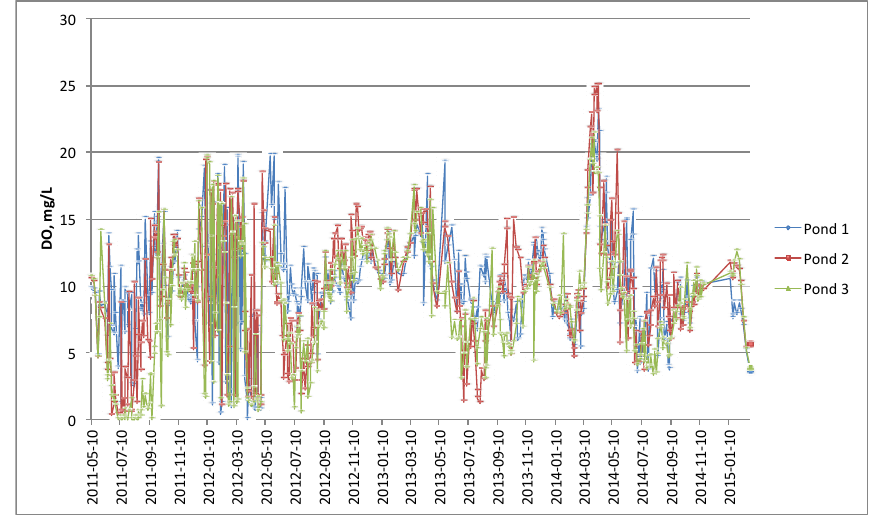
Figure 5. Changes in DO concentrations in the effluents of Pond 1, Pond 2 and Pond 3 over the four-year monitoring period.